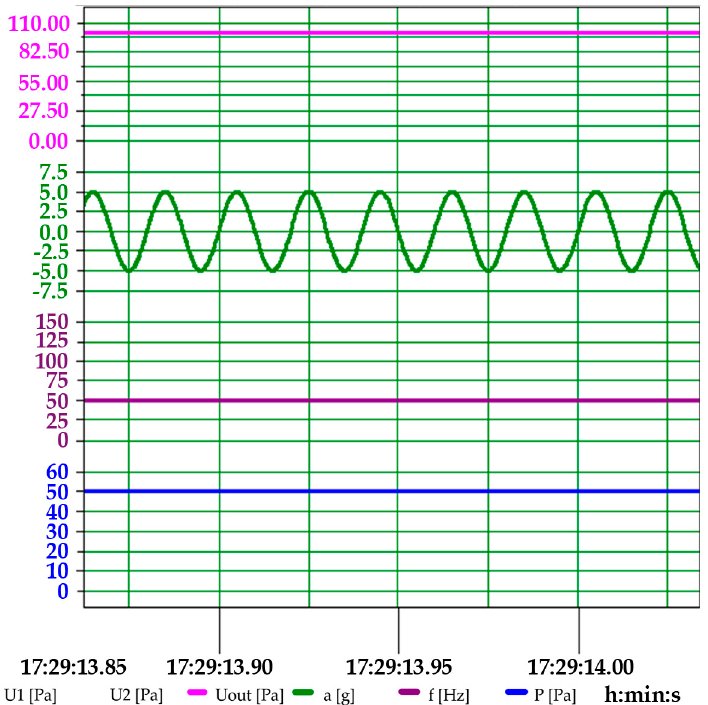
Figure 21. Waveforms of the experimental values of acceleration (a), pressure (p), and output signal (U out ) for dynamic acceleration with vibrations and with an amplitude of 5 g, frequency of f = 50 Hz, and pressure excitation of p = 50 Pa for the double-membrane transducer.